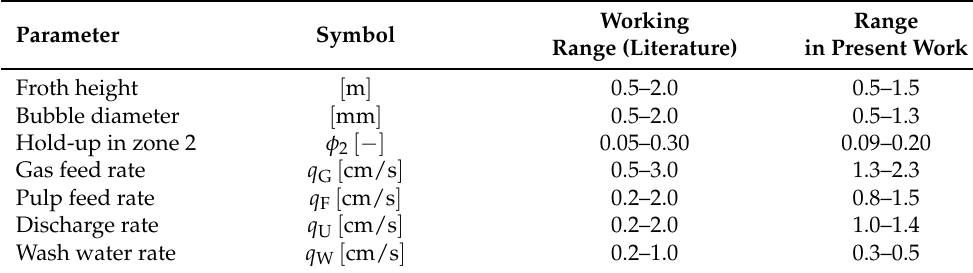
Table 4. Range of parameters according to the literature (typical values employed in [43–47]) and used in the present